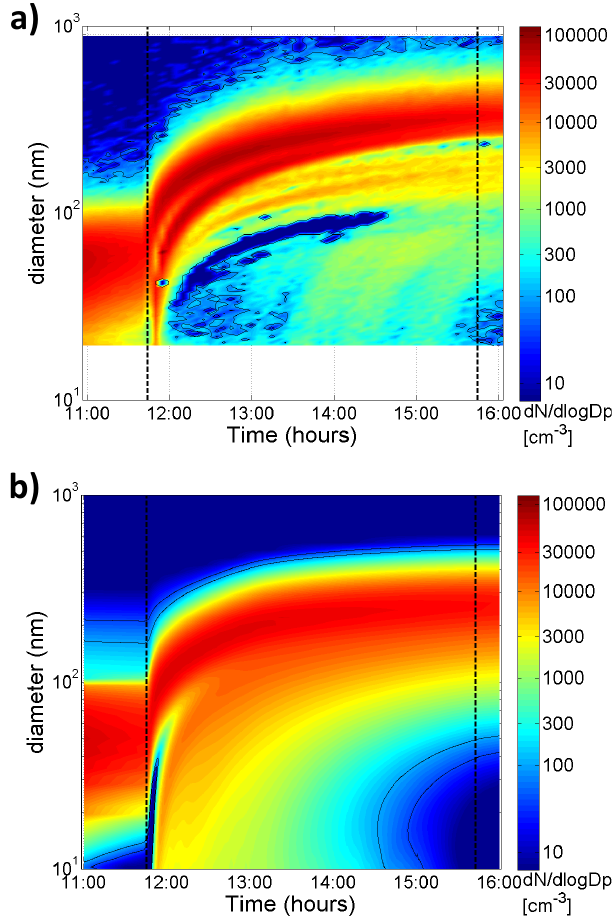
Fig. 6. Sequential number size distribution ( dN/d log D p in # cm − 3 ) during experiment E3 (a) recorded by the SMPS, (b) ob- tained from a simulation with MAFOR. Diameter range shown is from 10nm to 1000nm. The lower size cut-off of the SMPS instru- ment was at 19.5nm. Vertical black dashed lines indicate beginning and end of the sunlit